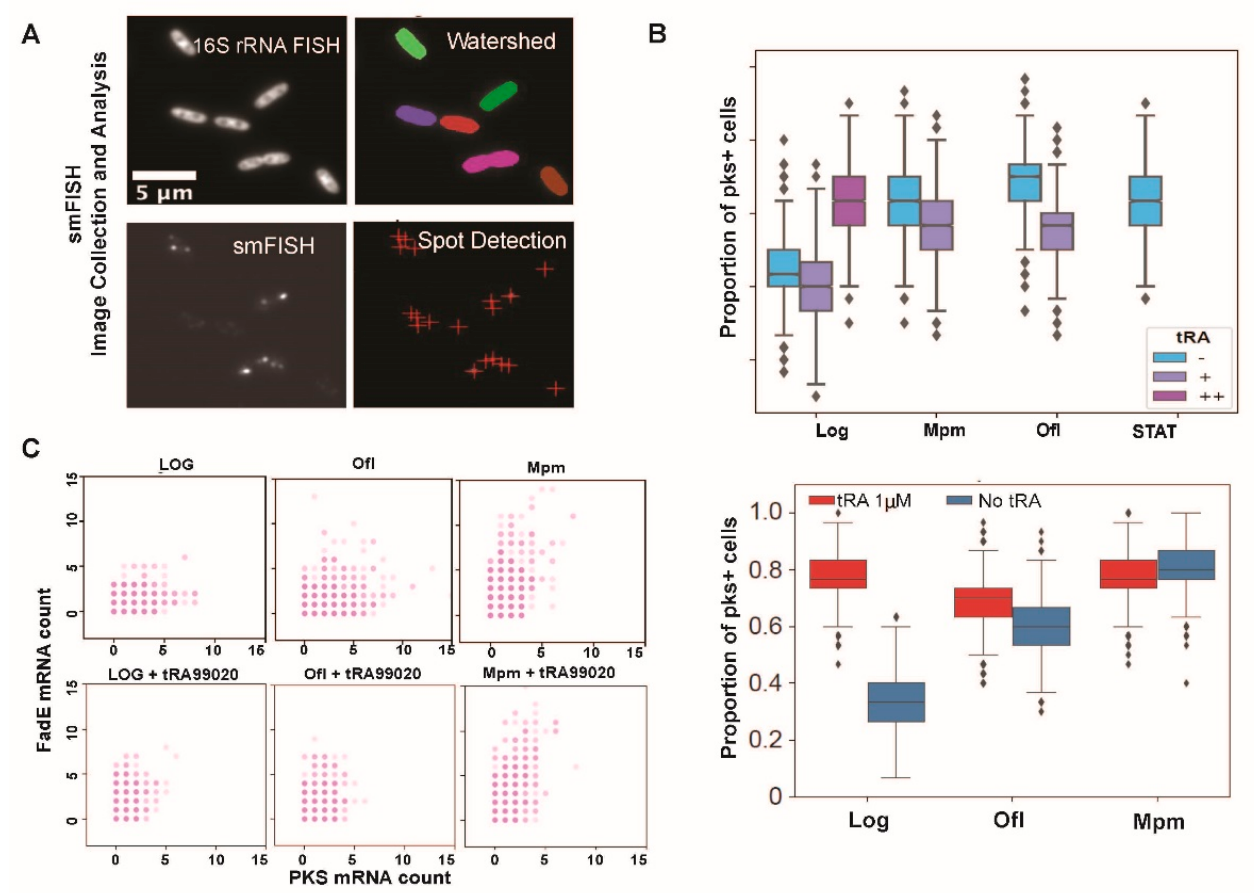
Figure 3. Analysis of persistence pks gene expression in B. thailandensis E264 populations on the single-cell level via smFISH in response to tRA99020 and antibiotic treatment. ( A ) Fluorescent microscopy imaging of 16S rRNA FISH probes were used for watershed segmentation and smFISH